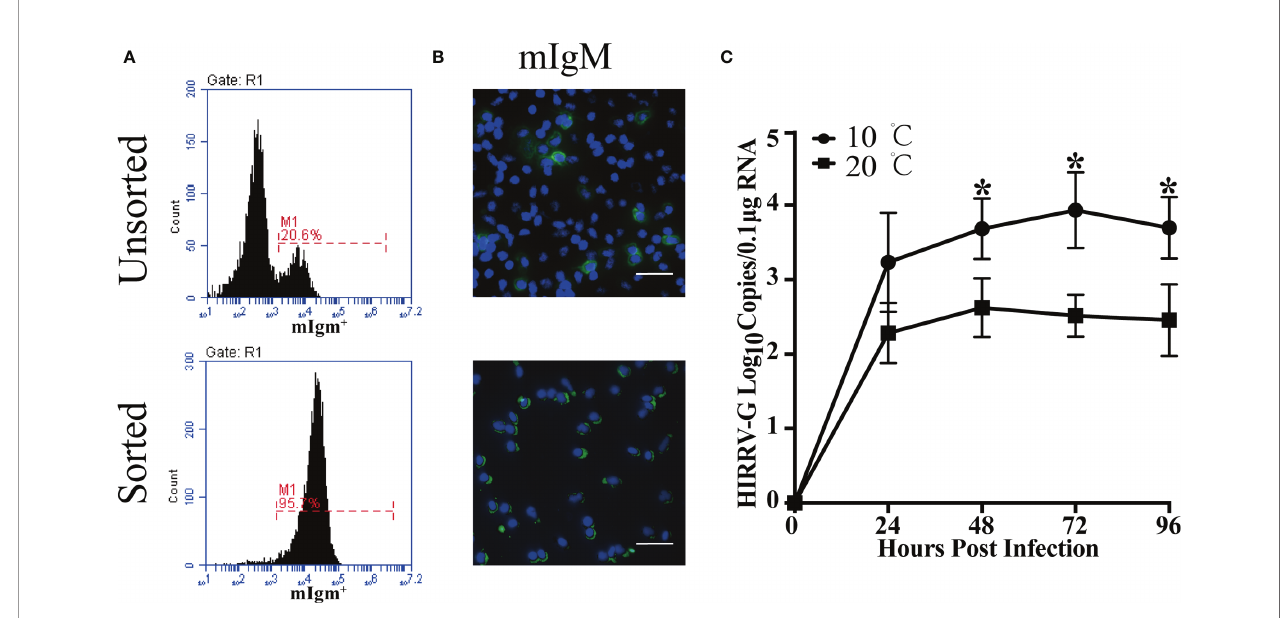
FIGURE 2 | Detection of HIRRV replication in the sorted mIgM + B lymphocytes. (A) Flow cytometry results of unsorted and sorted mIgM + B lymphocytes from PBLs (24 hpi). (B) Immuno fl uorescence staining results of unsorted and sorted HIRRV + /mIgM + B lymphocytes. Bar = 20 m m. Mouse anti- fl ounder IgM mAbs were used in this experienment. (C) The changes of viral copy numbers in mIgM + B lymphocyte of HIRRV infected fl ounder maintained at 10°C and 20°C. Mean viral copy numbers and standard deviation were represented in log 10 scale. The results were presented as the means ± SEM of three individuals, asterisk indicate signi fi cant difference between 10°C and 20°C infection groups ( p <